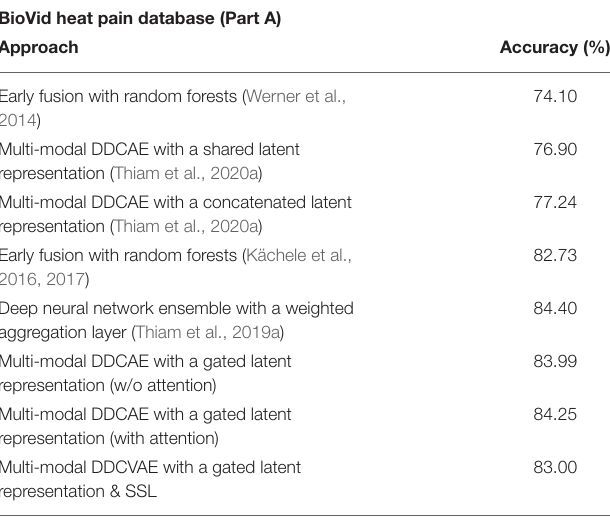
TABLE 7 | Classification performance comparison with previous works (BioVid Heat Pain Database: T 0 vs . T 4 ). BioVid heat pain database (Part